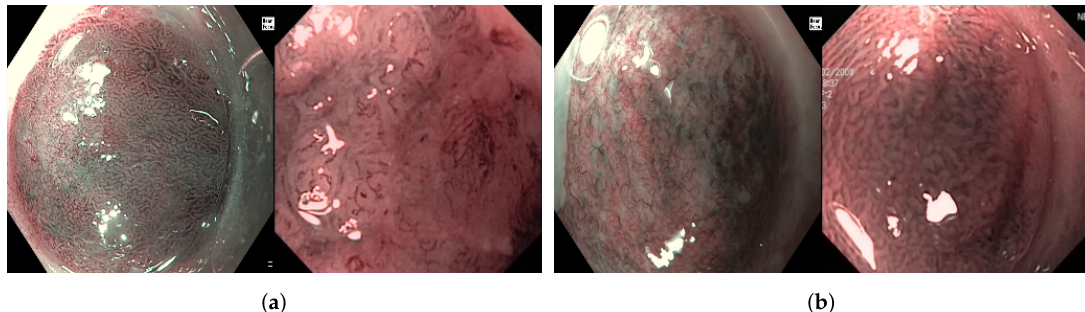
Figure 1. ( a ) Two examples of dysplastic lesions. ( b ) Two examples of non-dysplastic